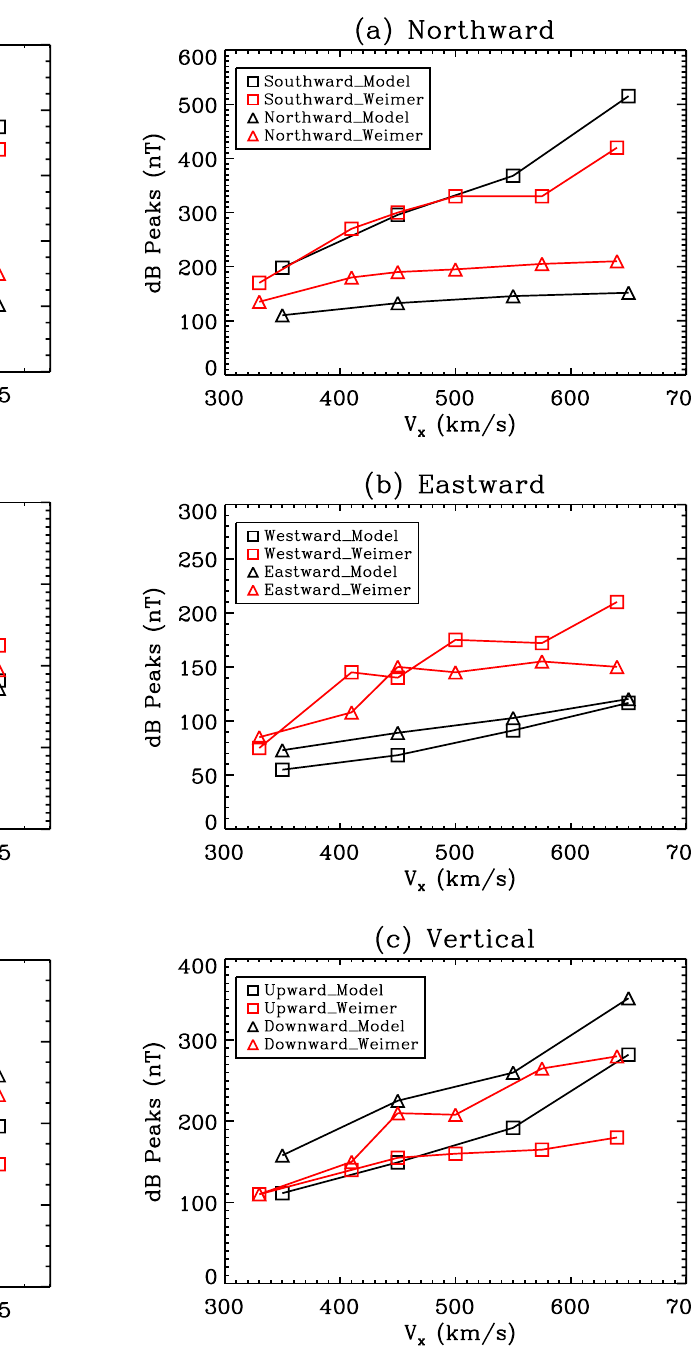
Fig. 9. Peak values of the geomagnetic perturbations as a function of the solar wind velocity. The three graphs show the (a) northward, (b) eastward, (c) vertical components. Triangle and square symbols represent the absolute values of most positive and negative pertur- bation, respectively. Black lines denote the simulation results, red lines denote the statistical